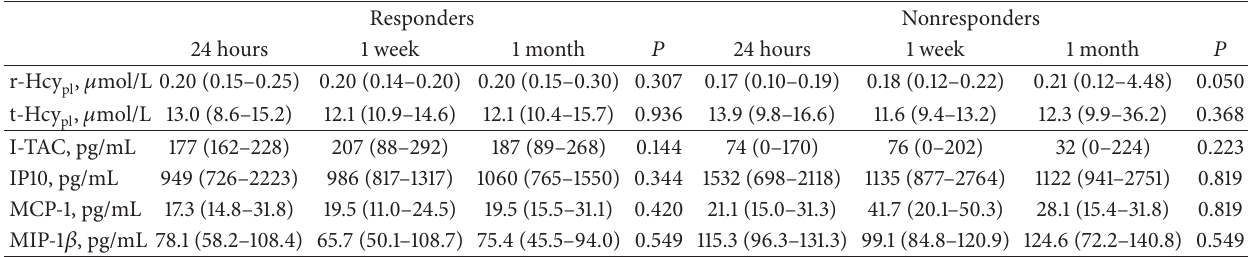
Table 4: Time-dependent changes of Hcy and chemotactic molecules levels.